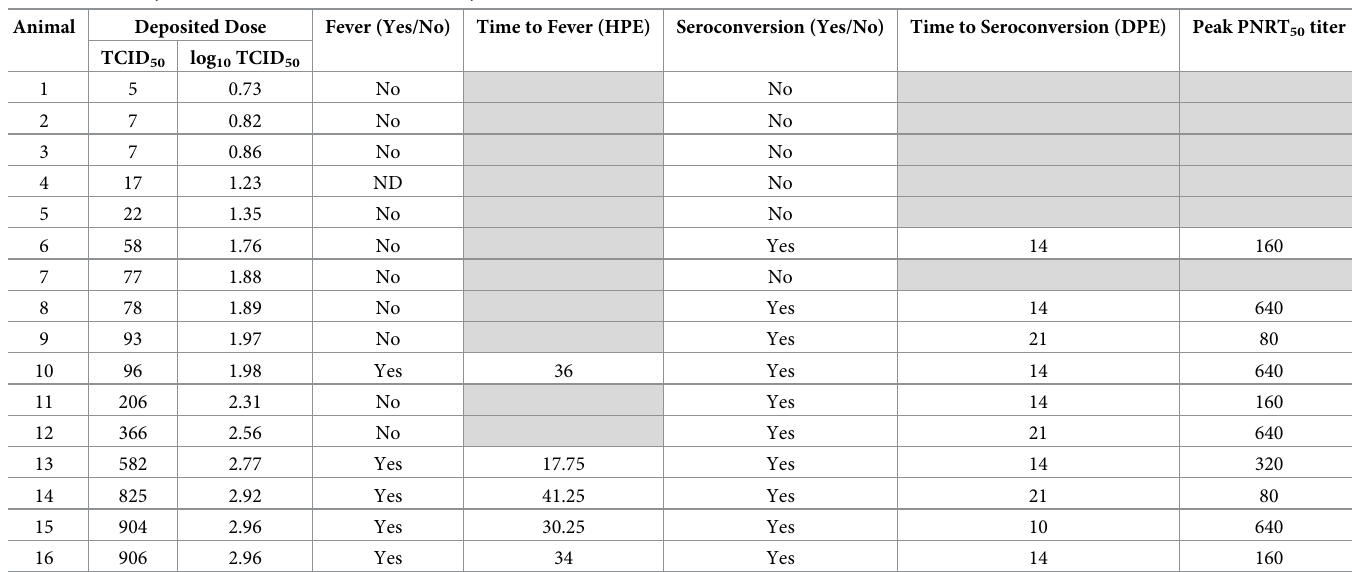
Table 1. Summary of fever and seroconversion results by